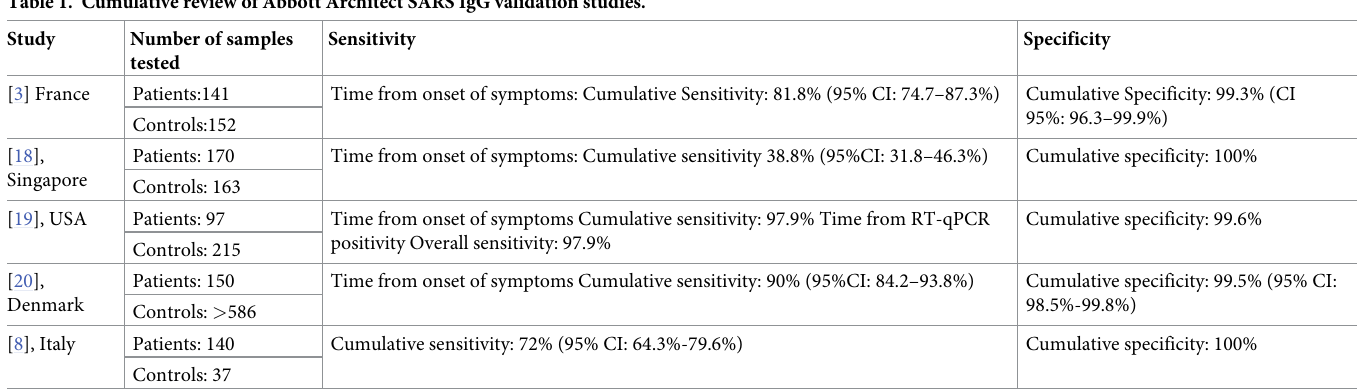
participants first and thereafter they were asked to sign the written informed consent form.